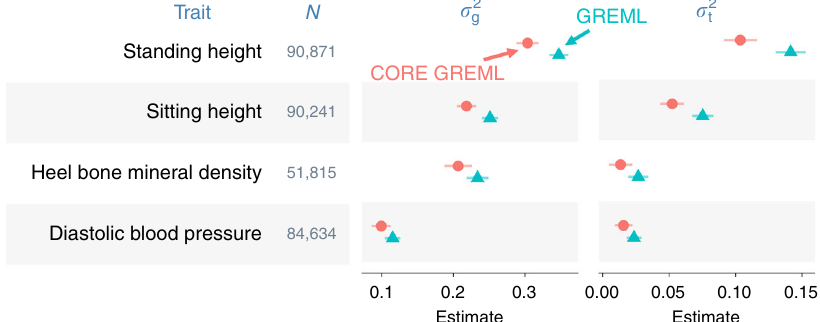
and σ 2 denote the phenotypic variances explained by g t